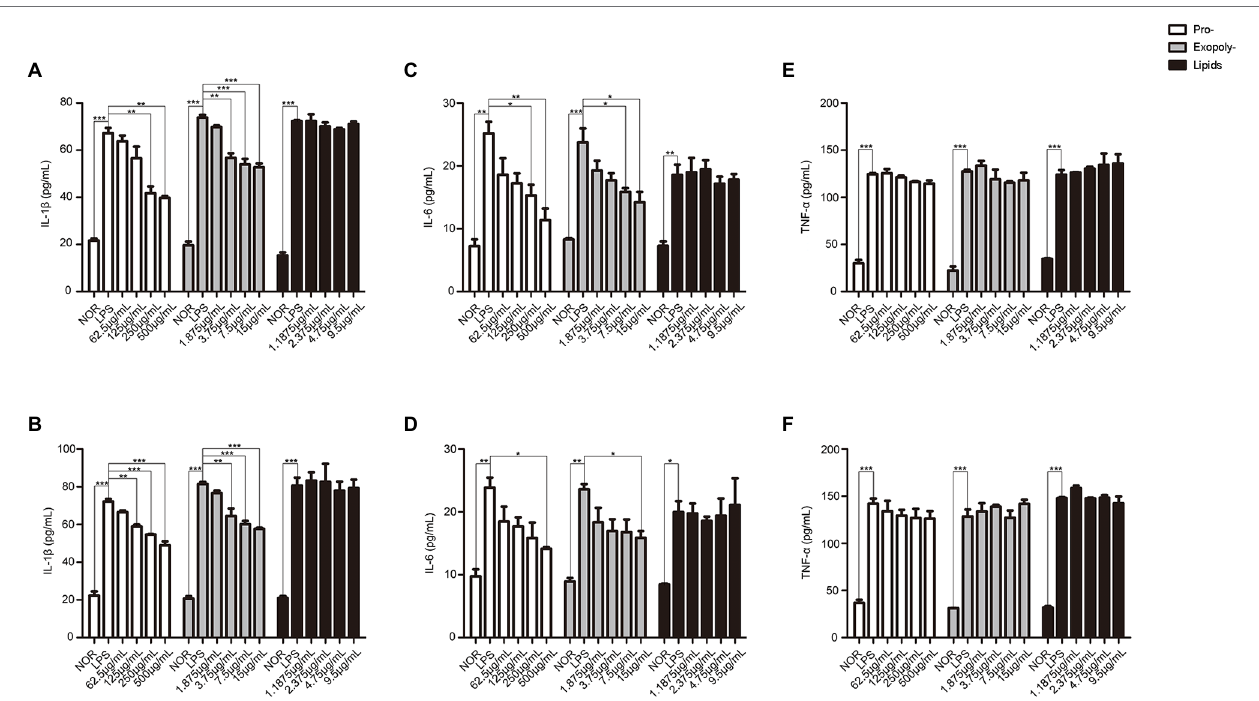
FIGURE 9 | The levels of IL-1 β , IL-6, and TNF- α in caco-2 cells after treated with exopolysaccharides, protein, and lipids separated from MLF. IL-1 β (A) , IL-6 (B) , and TNF- α (C) levels were examined in the supernatant of Caco-2 cells which were pretreated with 50 μ g/ml LPS for 12 h, then treated with exopolysaccharides, protein, or lipids for 12 h. IL-1 β (D) , IL-6 (E) , and TNF- α (F) levels were examined in the supernatant of Caco-2 cells which were pretreated with 50 μ g/ml LPS for 12 h, then treated with exopolysaccharides, protein, and lipids for 24 h. All groups were statistically analyzed with the LPS group. Data are expressed as means ± S.E. * p < 0.05, ** p < 0.01, and *** p <